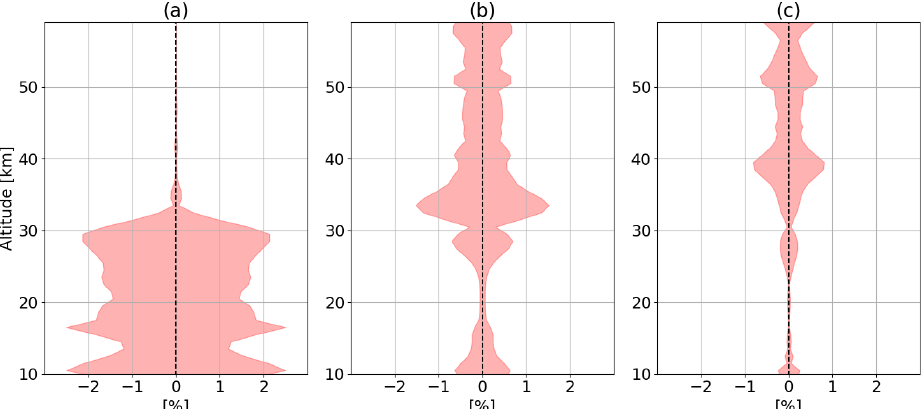
Figure 9. Standard deviation of 50 retrieved ozone profiles using a perturbed cross section: in panel (a) adding a random bias of 2% (constant over wavelength) in the Chappuis band, and in panel (b) adding random noise with an amplitude of 2% in the UV. (c) Standard deviation of 50 ozone profiles after perturbing the temperature and pressure profiles to investigate the uncertainty from the cross section temperature dependence.